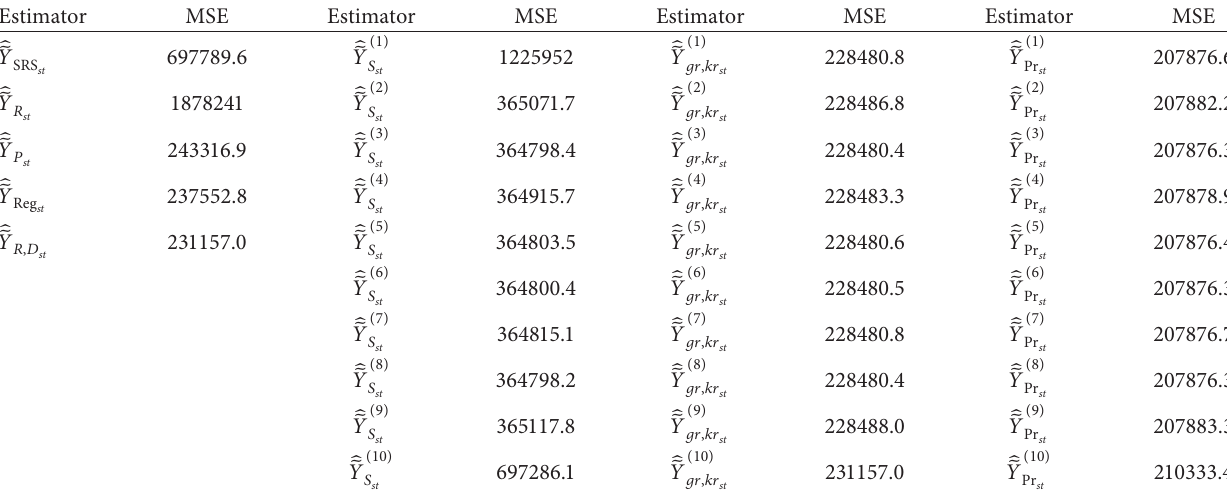
Table 9: MSEs using population 2 (scenario